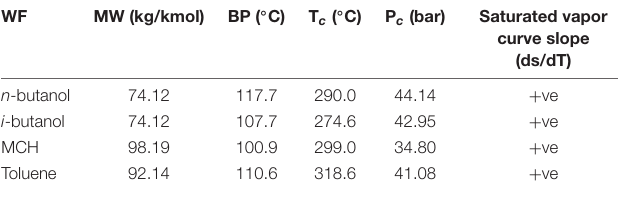
TABLE 1 | Thermo-physical properties of toluene, methylcyclohexane, n -butanol, and i -butanol.